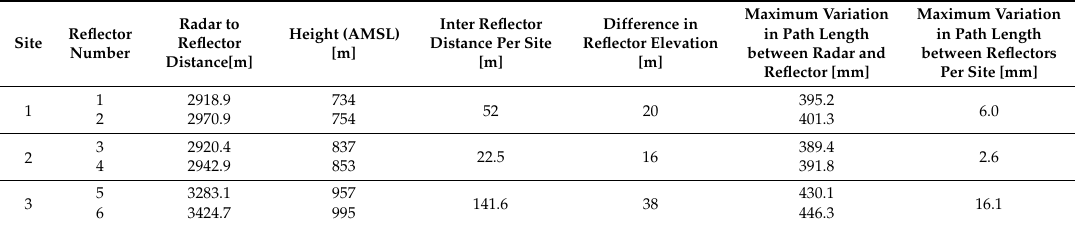
Table 3. Key parameters for each site. The maximum variation in path length for both radar-to-site and reflector-to-reflector per site are listed.